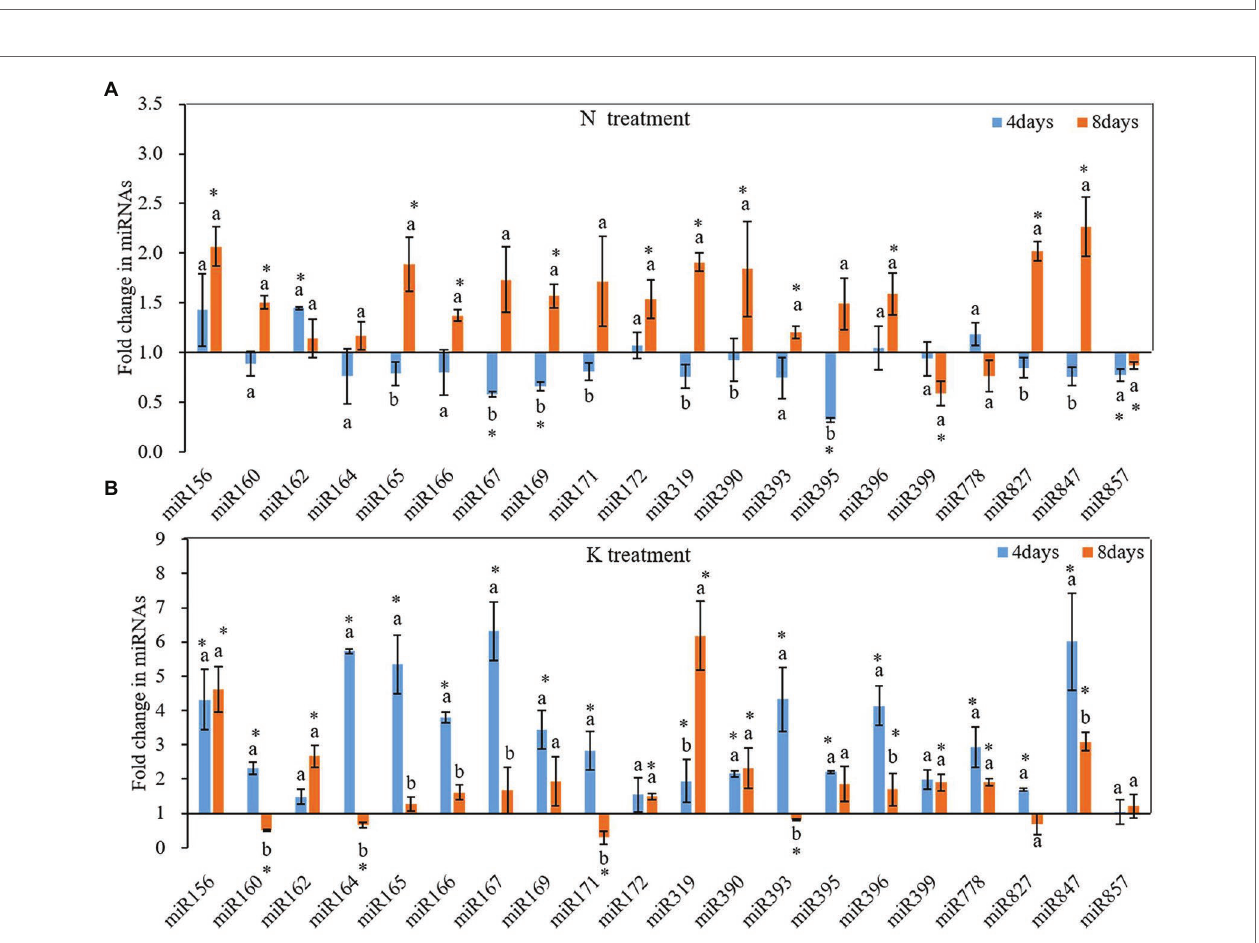
FIGURE 5 | Fold change of microRNAs (miRNA) expression between N deficiency and the controls (A) and between K deficiency and the controls (B) in the root of peanut seedlings, respectively. Error bars represent SD ( n = 3). The different letters on the bars indicate significant differences in the fold change of miRNA target expression between 4 and 8 days of treatment according to the LSD test ( p = 0.05). A value of p less than 0.05 was considered as a significant difference between N deficiency and the controls (A) , and between K + deficiency and the controls (B) , which marked as ∗ in the graphs. N, nitrogen; K, potassium; and LSD, least significant